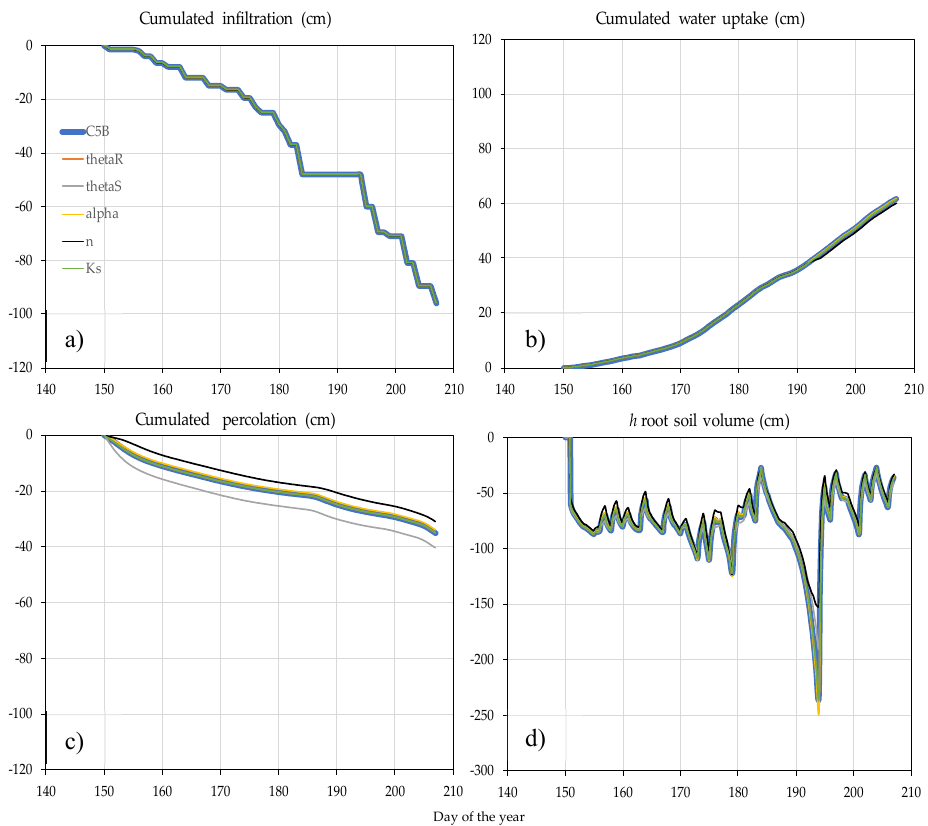
Figure 10. Temporal trend of soil infiltration ( a ), water uptake ( b ), percolation ( c ), and pressure head of soil root volume ( d ), obtained perturbating the van Genuchten parameters under the C5 approach.